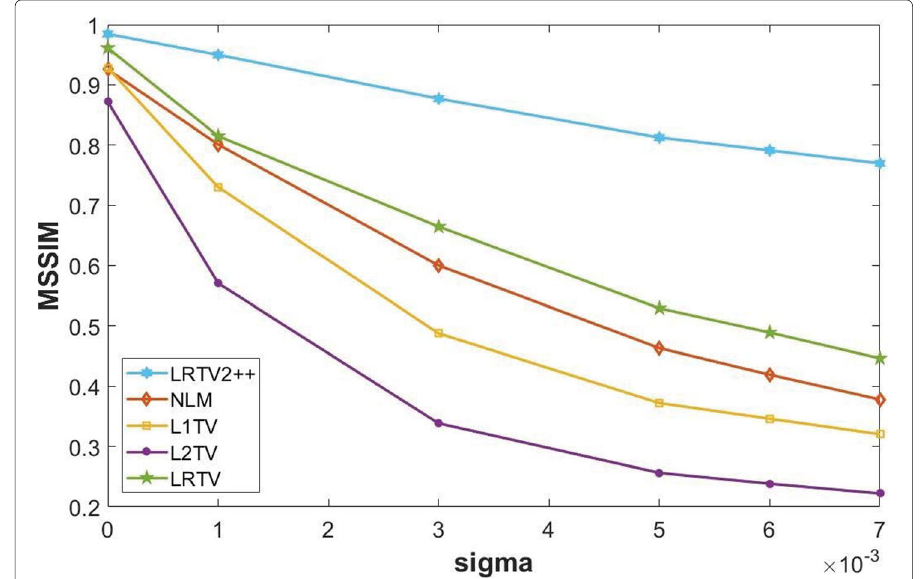
Fig. 2 SSIM of different methods with increasing noise variance from 0.001 to